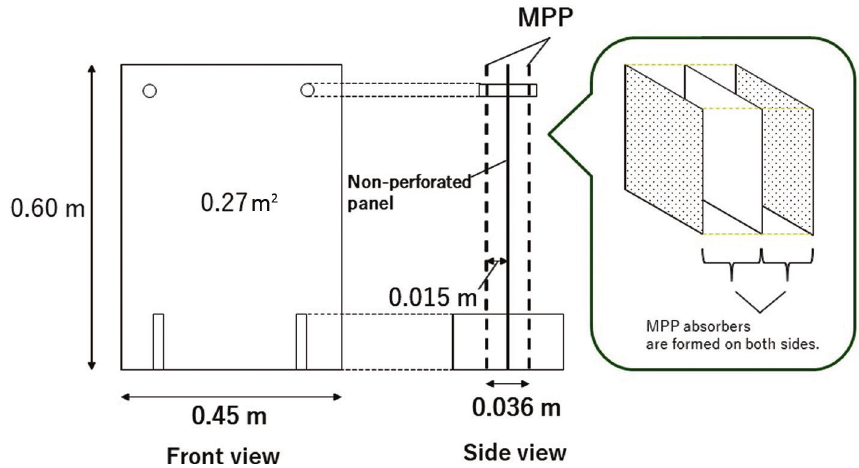
Design sketch of the prototype microperforated panel (MPP) acrylic transparent desktop partition. The area of the prototype in the figure describes one side. The acoustical concept of the overall sound-absorbing structure is summarised in the sketch on the right. The legs supporting the partition are 120 mm × 80 mm and made of 5-mm thick acrylic sheets. When placed on the floor, the three panels are almost in contact with the floor. All parts were made of acrylic and no damping material was used.